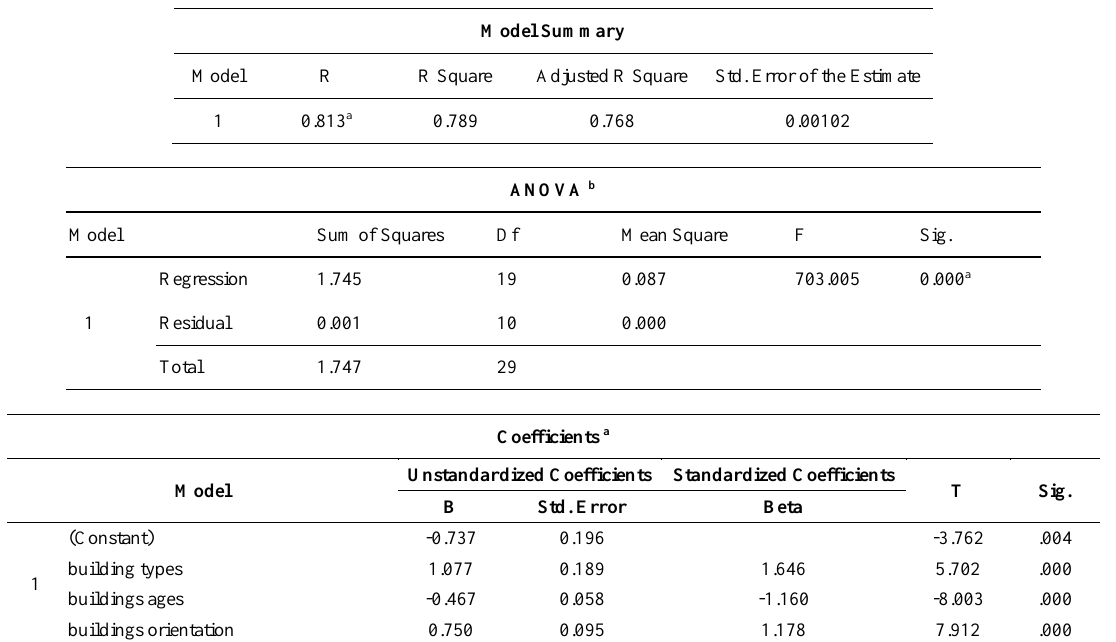
Table 15. Aggregate of Regression Analysis Showing Relationship between variables of NPCs and Neighbourhood